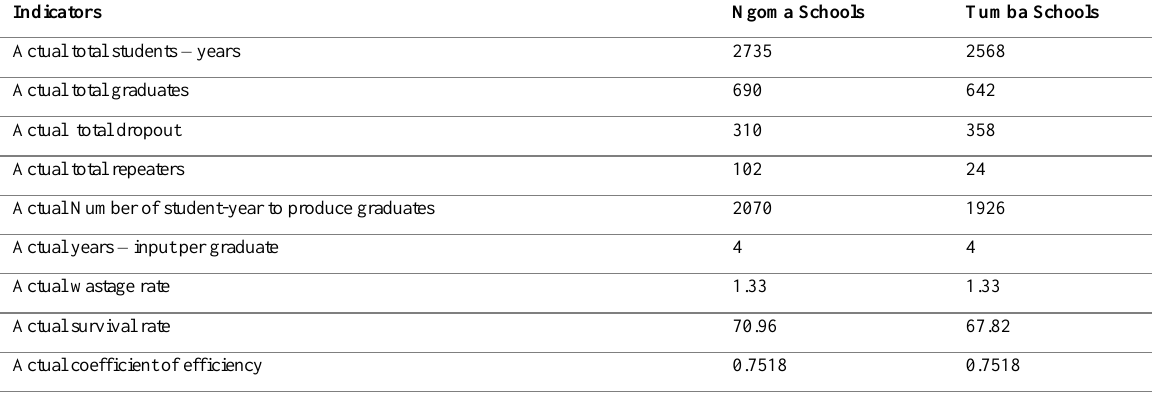
Table 2: Indicators of internal efficiency for the cohort